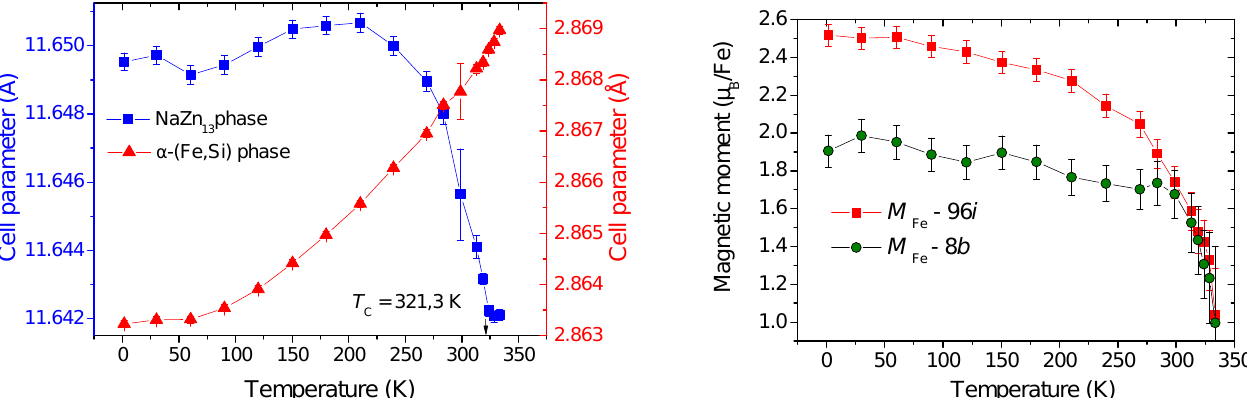
Figure 13. Unit cell parameter a vs. temperature for LaFe 11.5 Si 1.5 C 0.7 ( left ). Magnetic moments of Fe atoms vs. temperature, in the 96 i and 8 b crystallographic sites ( right ). The results are obtained from neutron diffraction